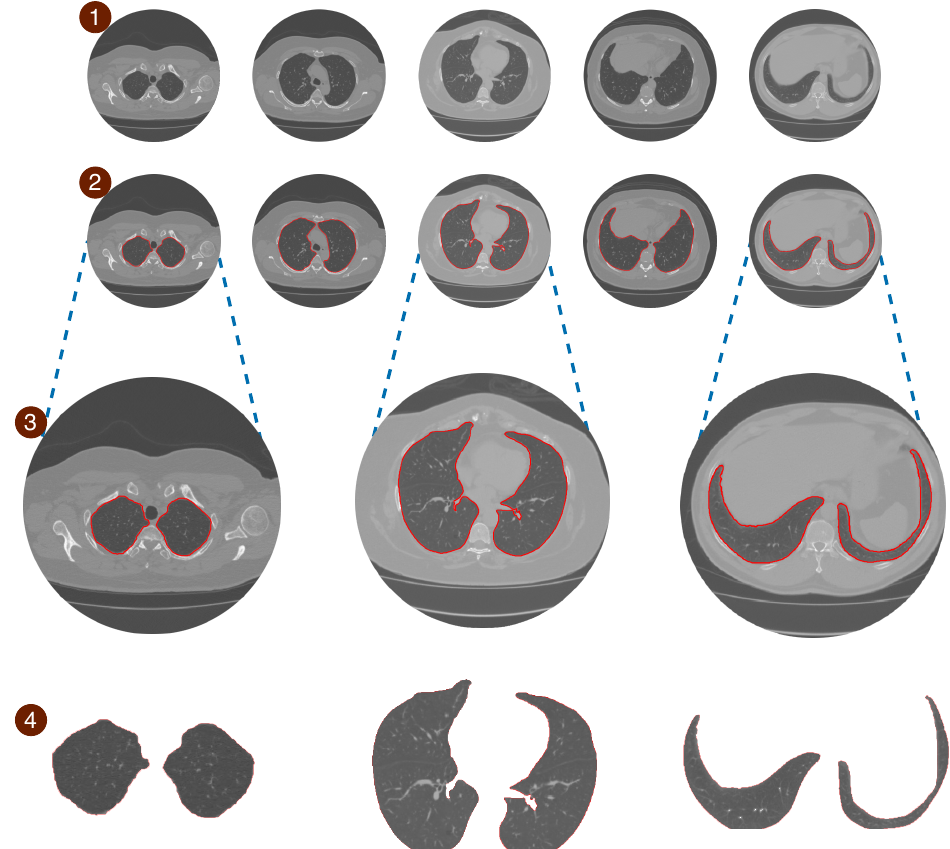
Figure 6. It presents the model’s segmentation differently; inline 1, the lung’s CT images are shown without segmentation methods. Inline 2, we offer the images already segmented by the proposed method. Inline 3, the images were enlarged for better visualization of the results. Inline four, the segmentation served as a basis for lung extraction for a better visual analysis of our model’s final